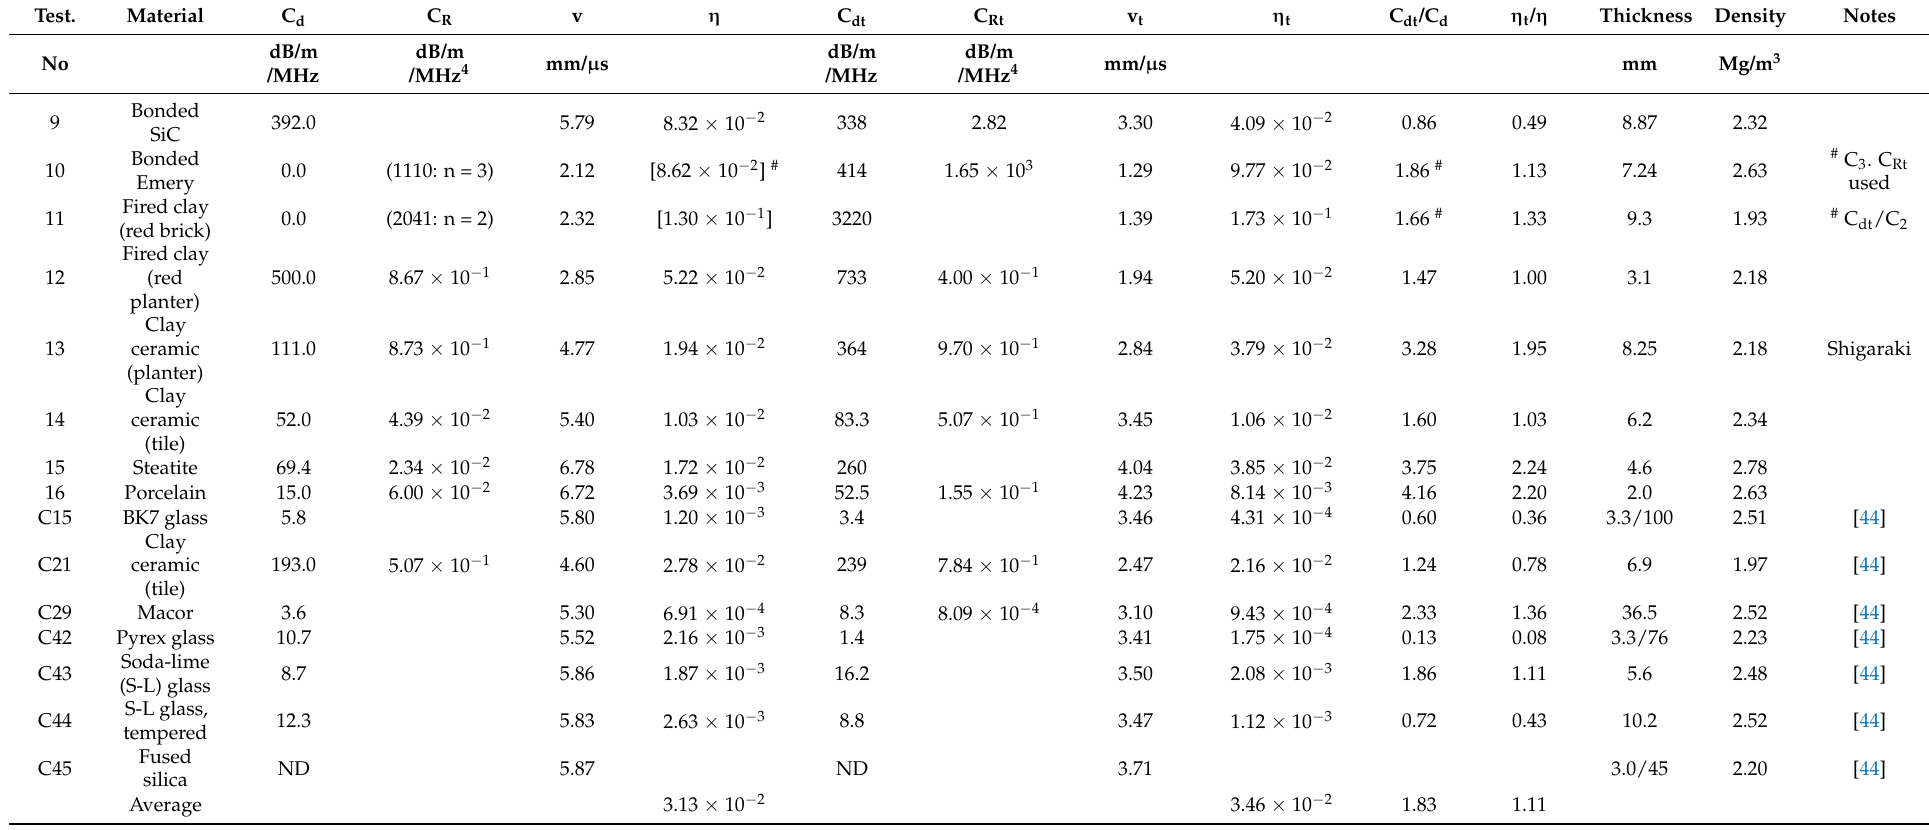
Table 5. Attenuation coefficients of longitudinal and transverse modes of glasses and common